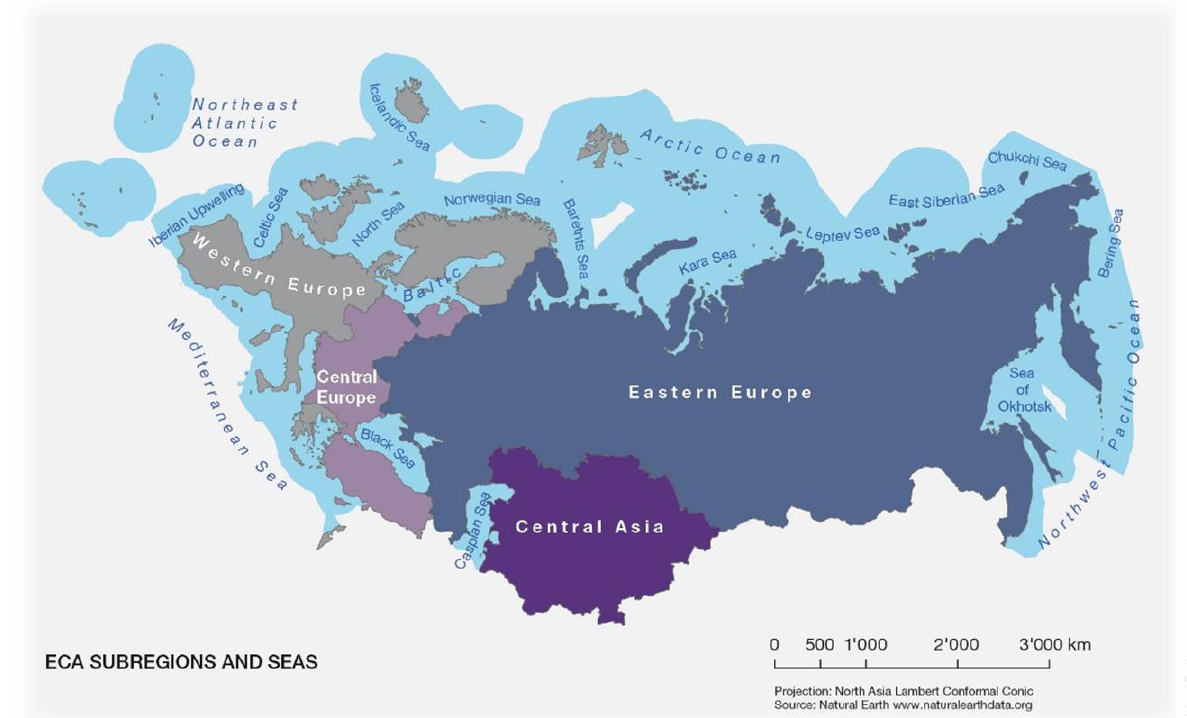
Figure A1.1: The four sub-regions of the IPBES Europe and Central Asia Regional Assessment. Source: Rounsevell et al.